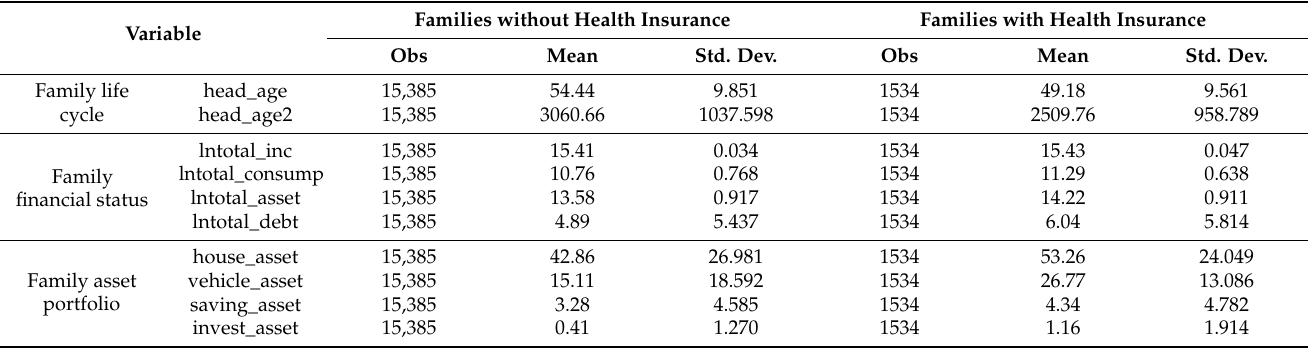
Table 2. Family life cycle, financial, and asset portfolio statistics of the sample by the possession of health insurance or